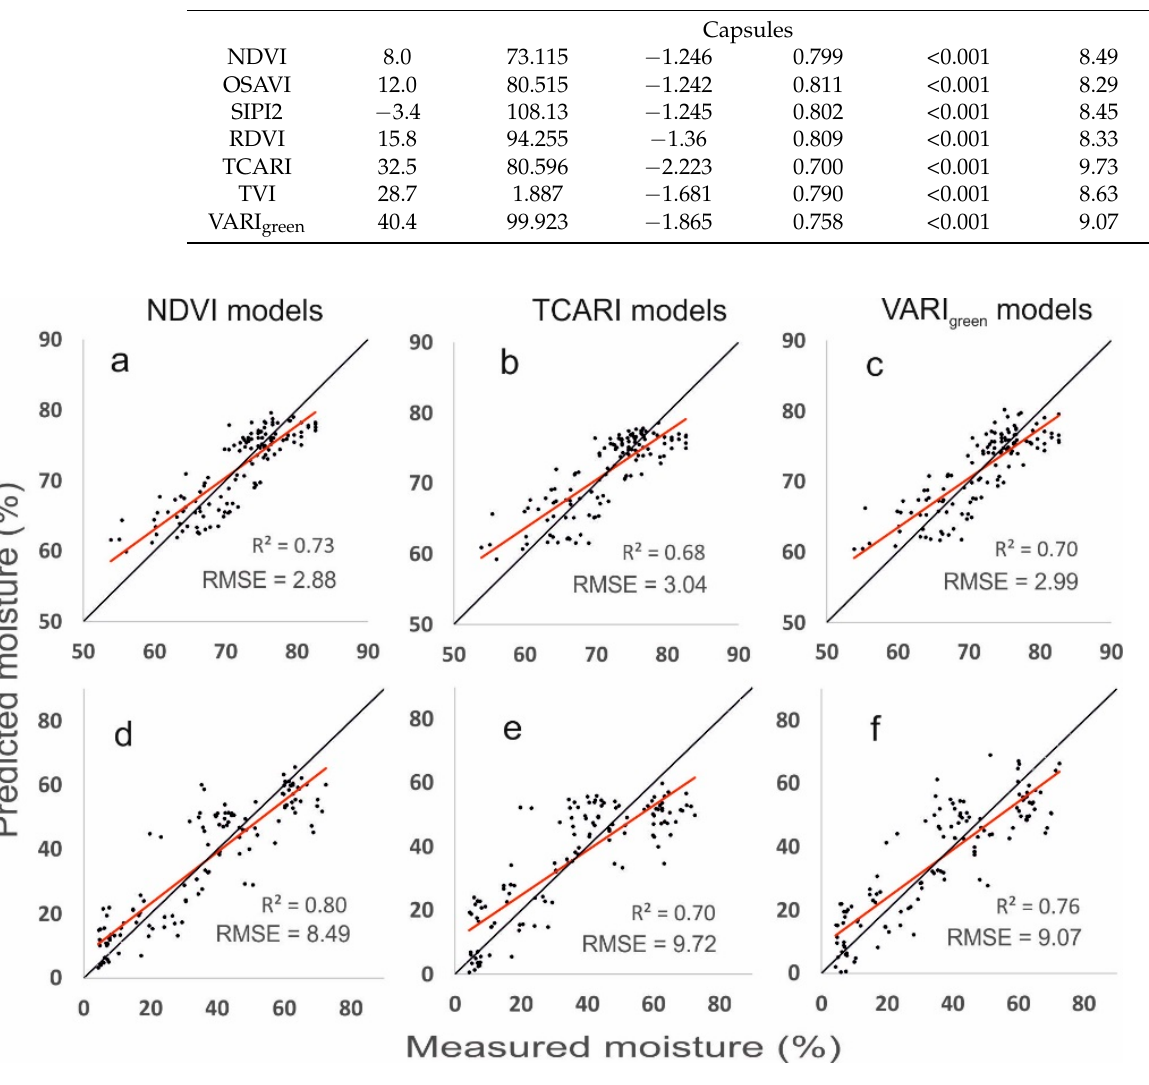
Figure 10. Relationships between measured moisture content and best model estimates based on NDVI ( a , d ), TCARI ( b , e ) and VARIgreen ( c , f ) models. The black line corresponds to the 1:1 line and the red dotted is the best-fit line.